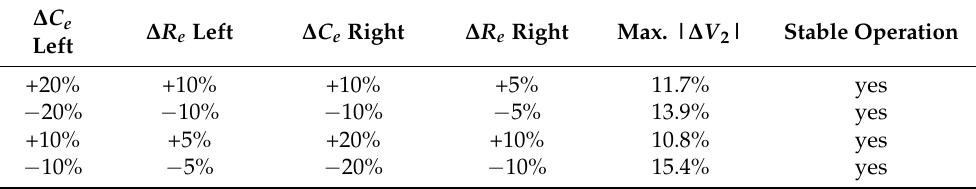
Table 10. Results of robustness analysis against variations of C e and R e in Scenario